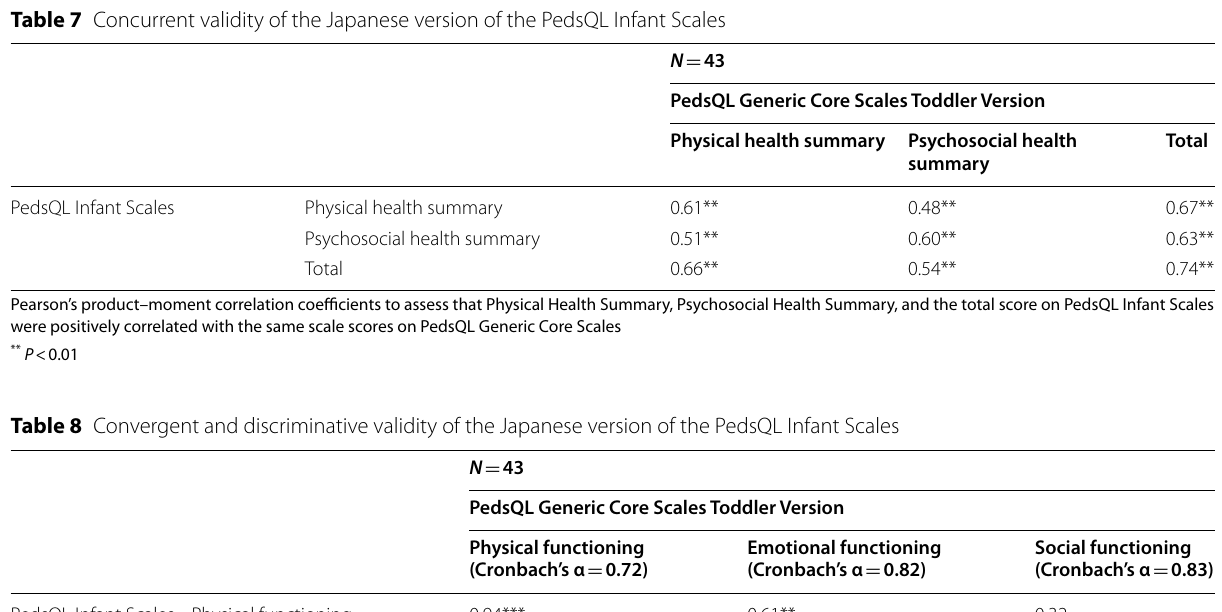
disease is 4.71 points lower than among those without acute disease